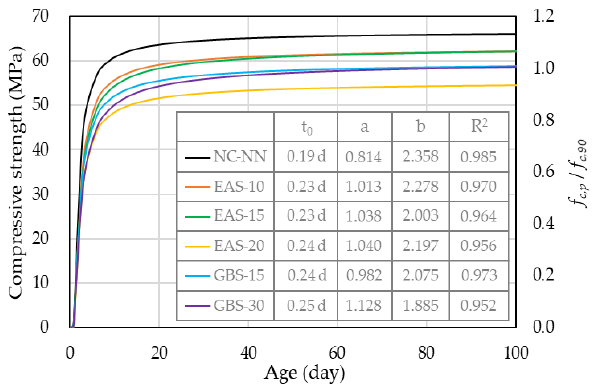
Figure 5. Test values for compressive strength. Figure 6. Prediction values for compressive strength.4.5. Shrinkage Behavior under Free Condition